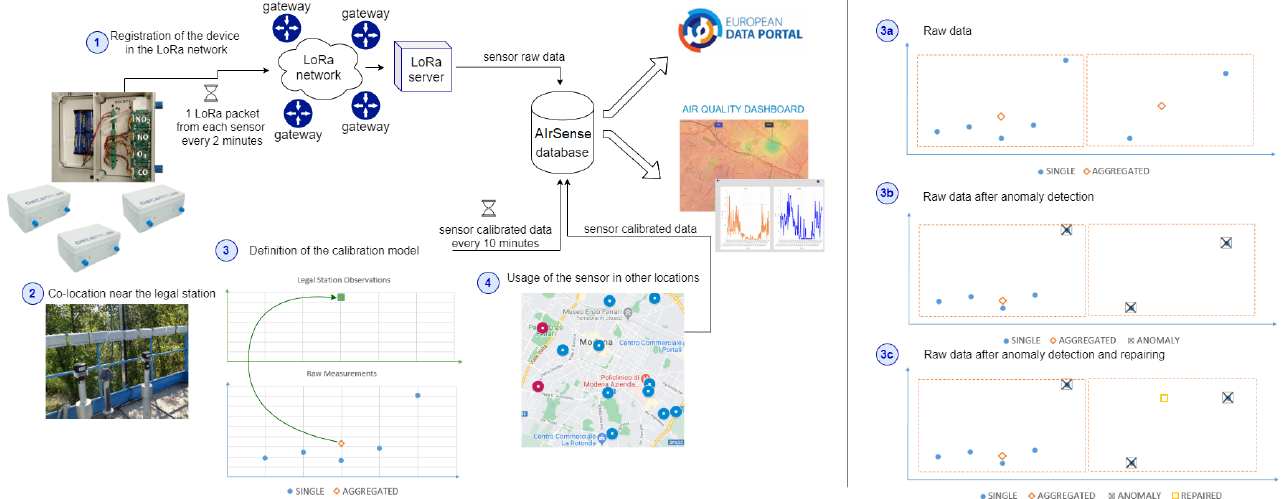
Figure 1. The production of raw data, calibration, and export in the AIrSense framework (on the left ) and the anomaly detection and repairing procedure on raw data (on the right